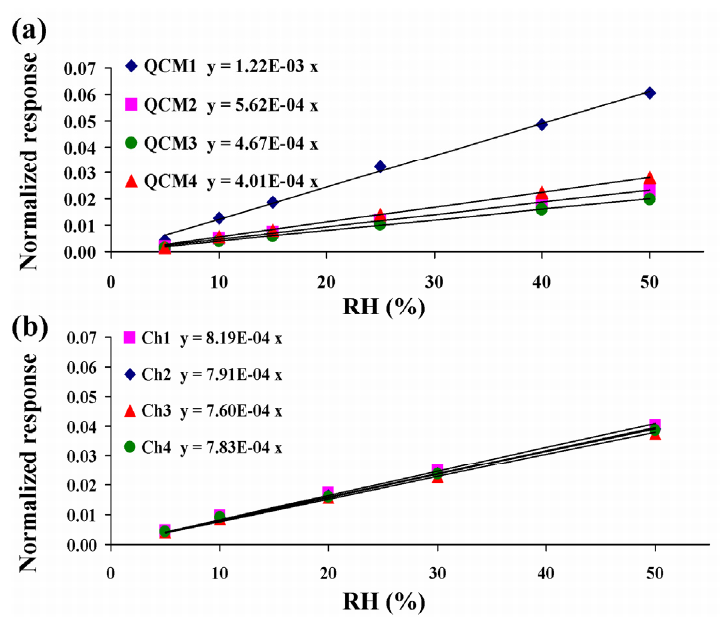
Figure 8. Normalized responses of the QCM sensors (a) and MQCM channels (b) vs. relative humidity